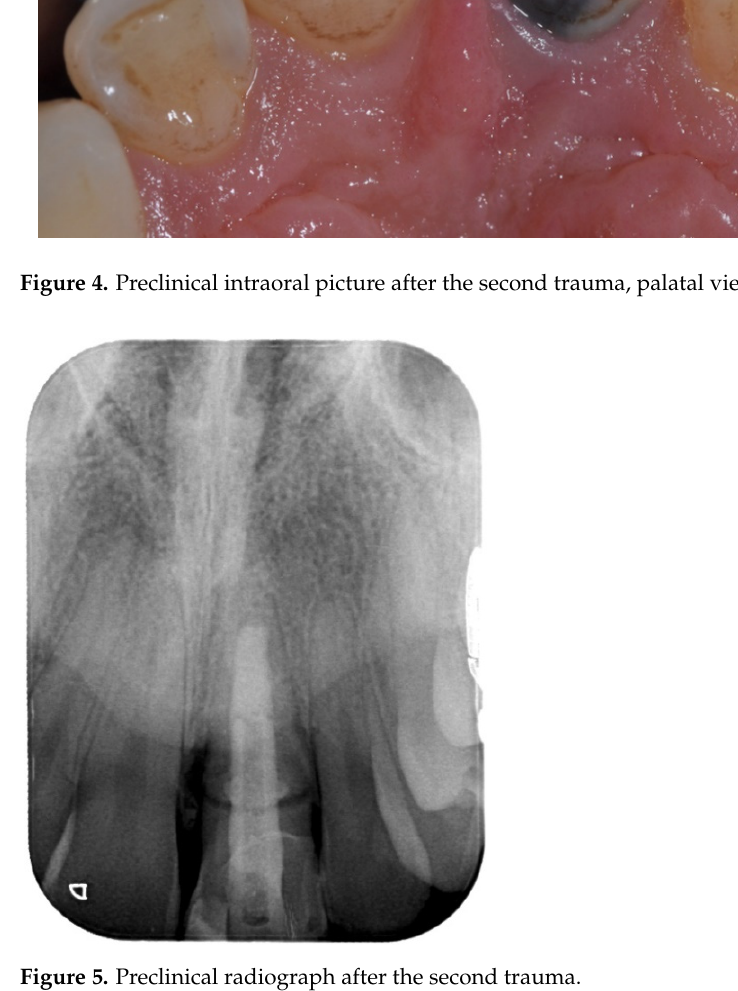
Figure 5. Preclinical radiograph after the second trauma.